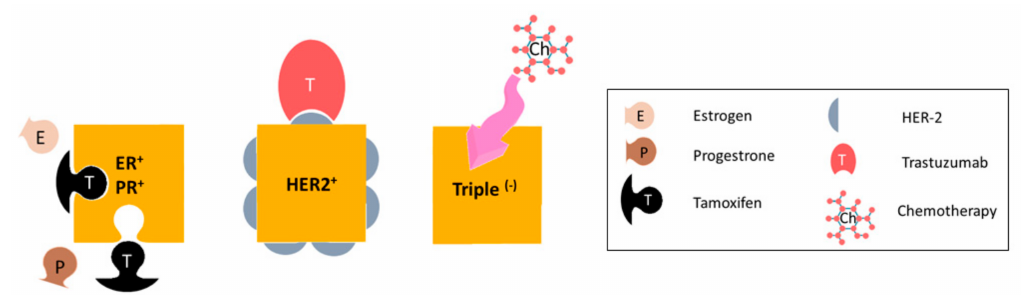
Figure 1. Subtypes of metastatic breast cancer, based on receptor expression. Hormone-receptor expressing tumors are treated with anti-hormone therapy (such as tamoxifen), HER2-expressing tumors are given targeted anti-HER2 monoclonal antibody therapy such as trastuzimab. The main treatment option for triple negative breast tumors is